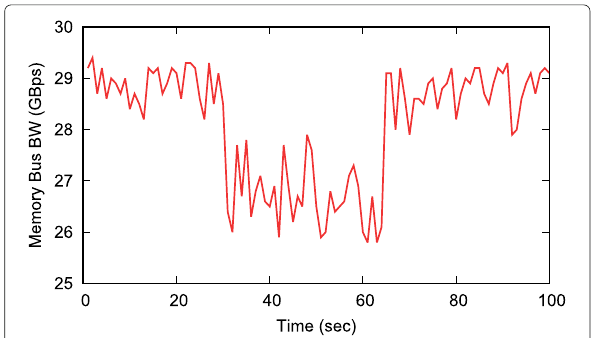
Fig. 3 Memory bandwidth during a cache template attack, as measured using Poker. A cache template attack is launched from a co-located VM between the 30th and 65th seconds. The figure shows the decrease in bandwidth measured by Poker during that